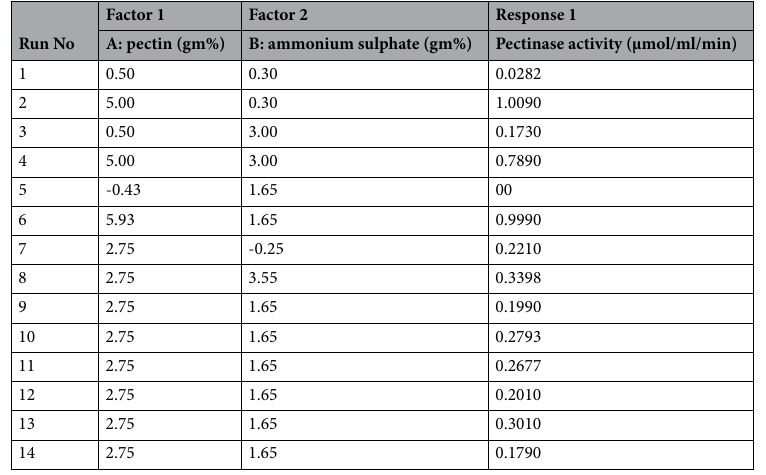
Table 7. Design matrix of 14 runs generated through RSM-CCD (Design-Expert software V10).